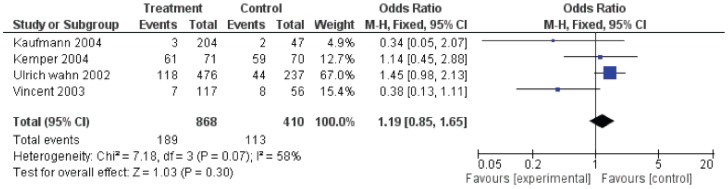
Analysis of total Adverse events.